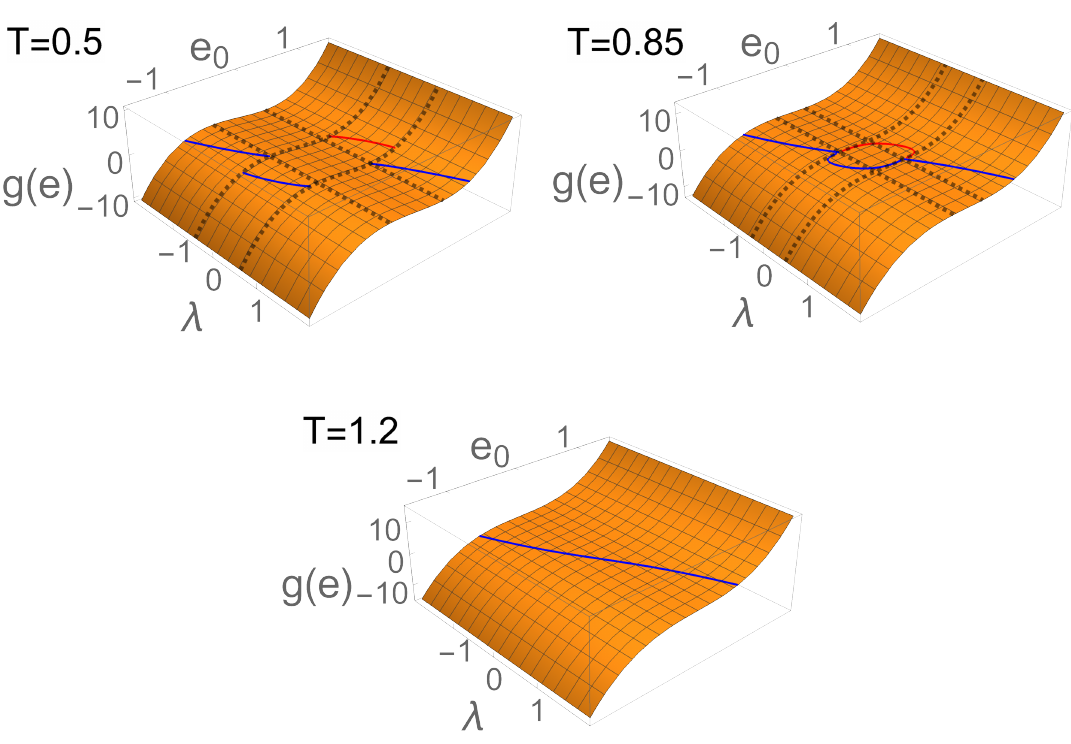
Figure 19 . The trajectories (red and blue curves) of the two solutions e 1 and e 2 as functions of λ for M = 2 , γ 1 = 1 and various T . The tri-critical point is at T = 5 / 6 . To highlight the way how the two solutions e 1 = e 2 = e ( − ) and e 1 = e 2 = e (+) depend on λ we also show the function g tm ( e ) . The dashed curves indicate the location of the phase transition. The dashed lines parallel to the λ axis are the “ridges” of the local minimum and maximum of g ( e ) given by (A.28), while the dashed curves parallel to e 0 are given by